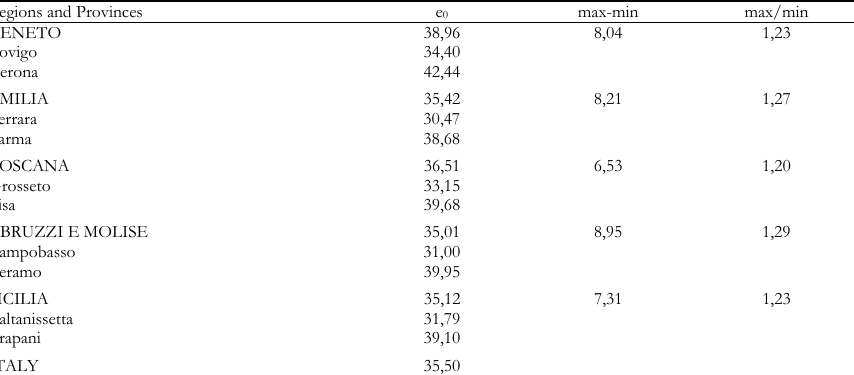
Maximum and minimum provincial values of e 0 in some Italian regions, 1881-82 (both sexes) Regions and